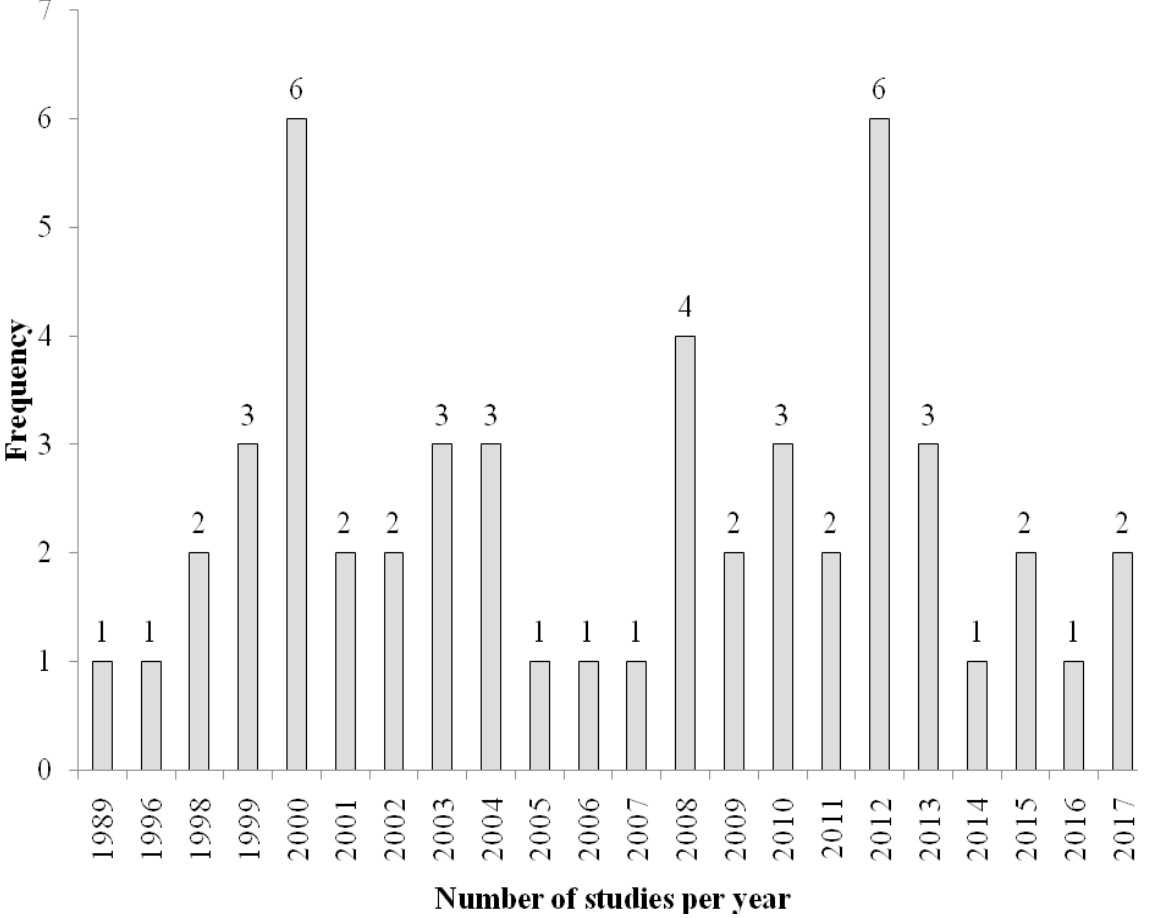
Fig 1. Historical series and frequency of the studies performed for the extraction of substances from ants, between 1989 and